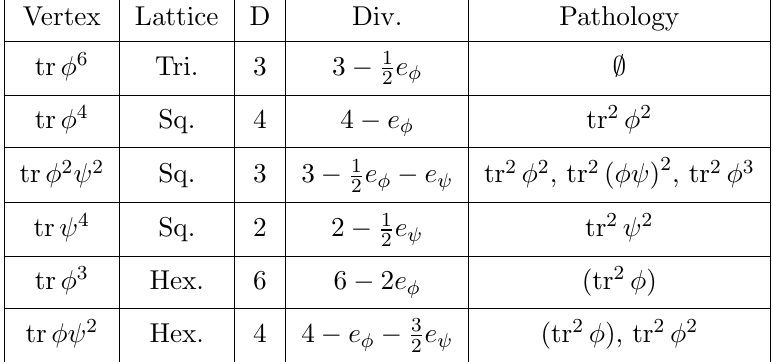
Table 1 . For each theory in 2.2 here the schematic form of the vertex, its dimension, the super(cid:12)cial degree of divergence of its diagrams with e (cid:30) external bosons and e external fermions. The last column lists the divergent diagrams present in the perturbative expansion. Since none of the divergences in the list can be absorbed by the counterterms of the Lagrangian, only semisimple (cid:30) 3 theories (when the Gauss’s law is imposed on external states) and (cid:30) 6 theories are immune to the radiation of additional terms in the